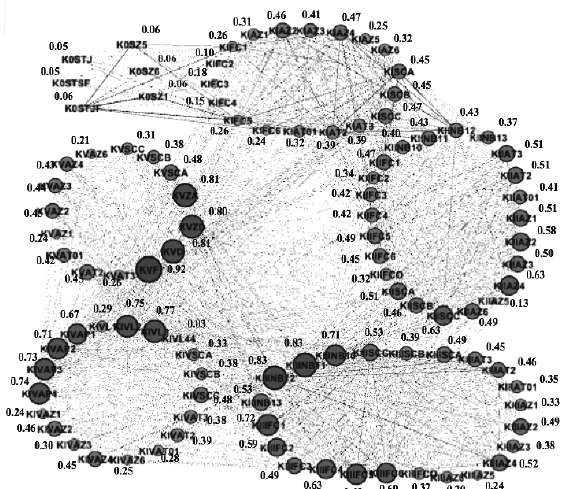
FIGURE 1. Network with Eigenvector Centrality for all variables related to the efficacy 0 in women’s volleyball. Terminology: in each node, codes are represented by the name of complex (e.g., KII), followed by the variable and its category (e.g., KIIAZ6 indicates that the action occurred in complex II, the variable in question was Attack Zone, and the category is Zone 6). Codes for the different variables: IPS – Initial Position of the Serve; ST – Serve Type (Jump, Jump-Float and Standing-Float); FC – Zone of First Contact; SC Setting Condition; AZ –Attack Zone; AT – Attack Tempo; BO – Block Opposition; KIVB – Number of Available Player Before of Attack Coverage; KIVL – Number of Coverage Lines; KVD and KVF – Downball and Freeball; KVTZ –Target Zone in KV (Attack or Defence